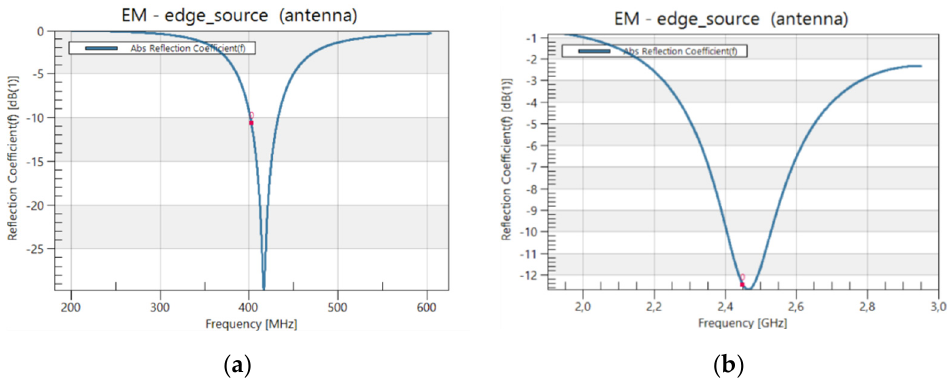
Figure 23 . Resonance performance at ( a ) 402.5 MHz and ( b ) 2.45 GHz of the female human phantom .